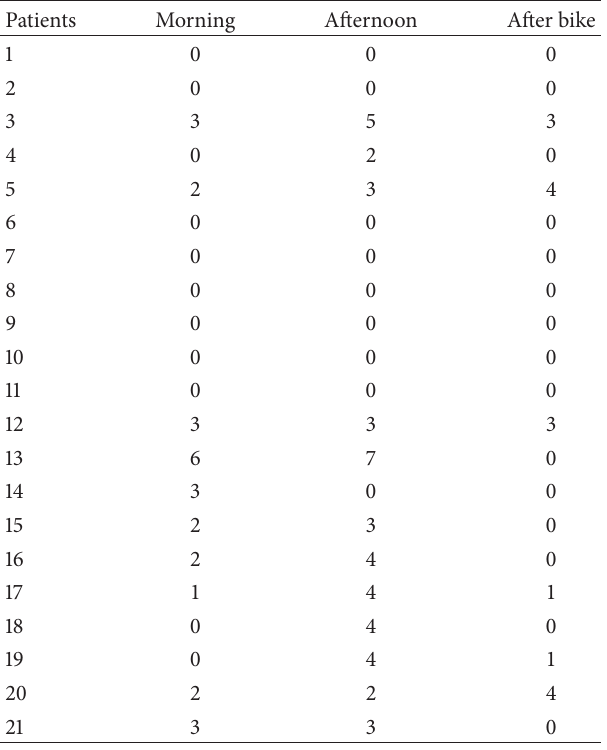
Table 1: Showing the pain scale values at the beginning of treatment (in the morning) and the afternoon after performing the bike. Patients Morning After